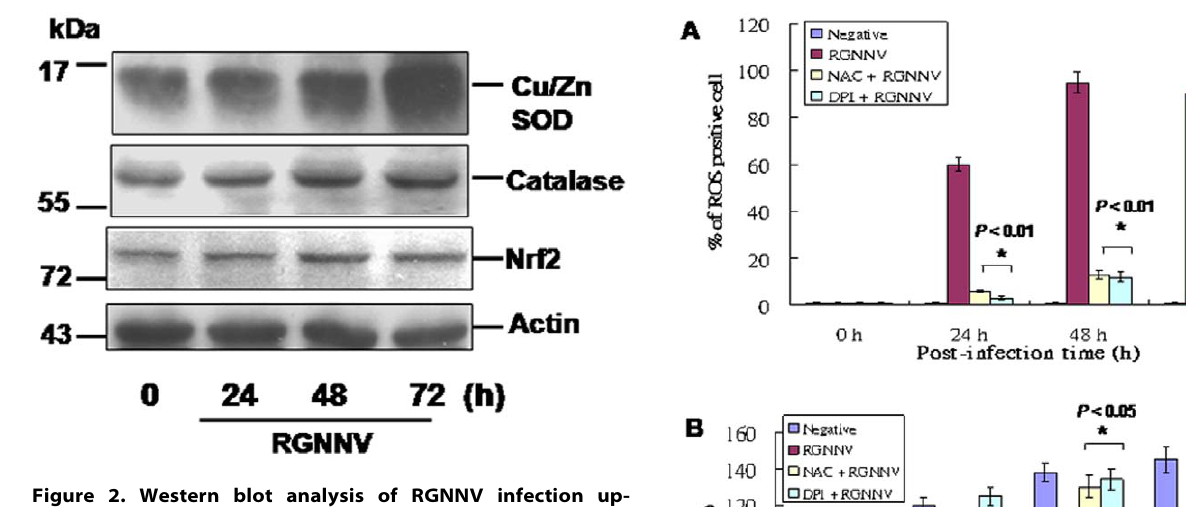
Figure 2. Western blot analysis of RGNNV infection up- regulates anti-oxidant enzymes Cu/Zn SOD and catalase or transcriptional factor Nrf2 in GF-1 cells at middle replication stage. The GF-1 cells pre-treated with antioxidants either NAC (1 mM) or DPI (30 mM) for two hours, then infected with RGNNV (MOI=1) for different time incubations at 0, 24, 48, and 72 h pi. Samples were electrophoresed on a SDS-polyacrylamine gel and electro-blotted to a NC membrane. The NC membrane was stained with mouse monoclonal IgG antibodies directed against Cu/Zn SOD (15-kDa; Cayman), Catalase (57-kDa; Rockland), and Nrf2 (74-kDa) (Rockland). The chemilumines- cent signal was imaged on XAR-5 film (Kodak) using a 5-min exposure. Lanes 1–4, 30 ul of virus-infected GF-1 cells and corresponded to 0, 24 h, 48 h and 72 h pi, respectively. The actin internal is also shown. doi:10.1371/journal.pone.0025853.g002 0.3–0.5 log in zfcapalase-contained cell groups, NAC and DPI, but